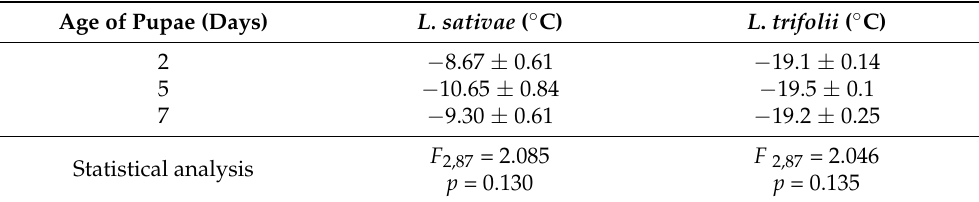
Table 1. Mean supercooling points (SCPs) ± S.E of pupae of different